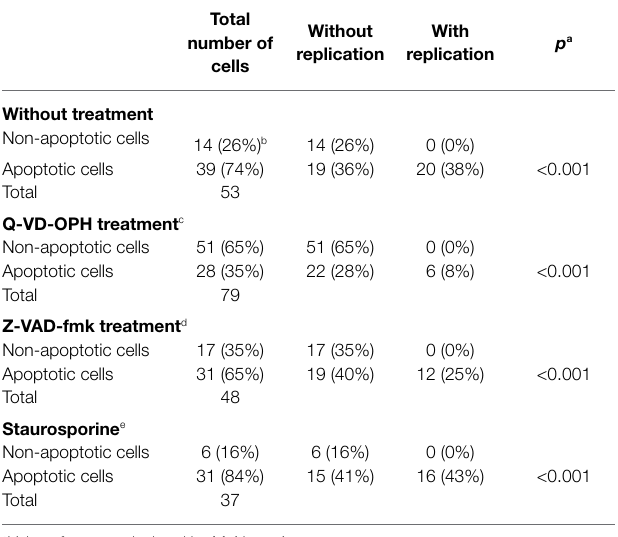
TABLE 1 | IAV replication in the apoptotic